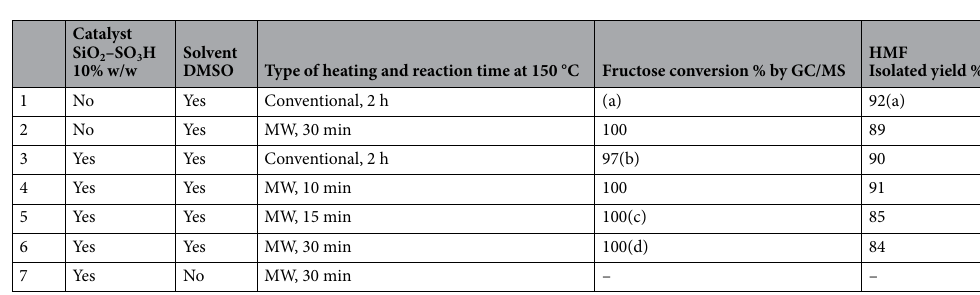
Catalyst SiO 2 –SO 3 H 10%